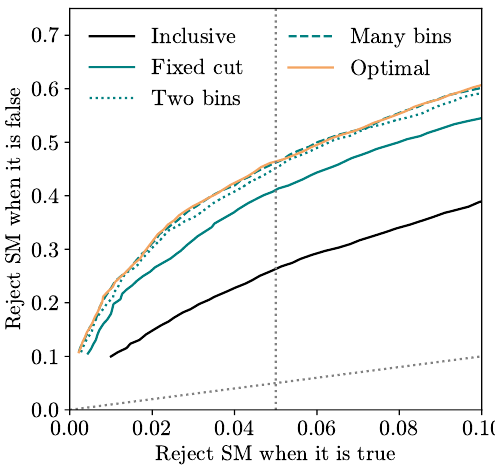
Figure 3: Results for a training with a fixed value of σ = 0.08. Left: histograms of the neural network outputs f ( y ) = NN of f ( y ) alongside a binned version of the likelihood ratio is presented alongside a Gaussian with mean zero and standard deviation 0.08.